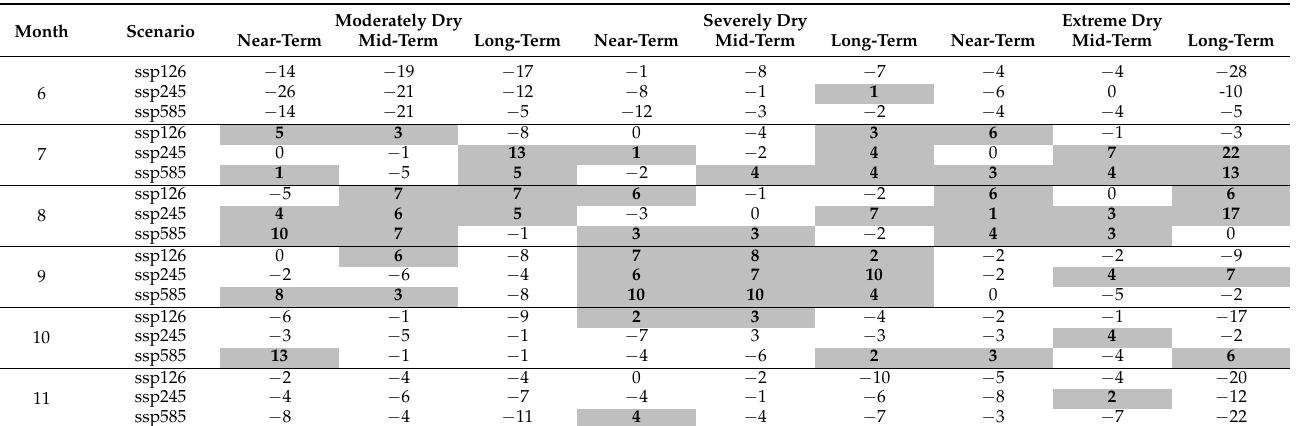
Table 5. Changes in frequency (times) of SRI-12 relative to the reference period for the near-, mid-, and long-term periods under the SSP1–2.6, SSP2–4.5, and SSP5–8.5 scenarios.